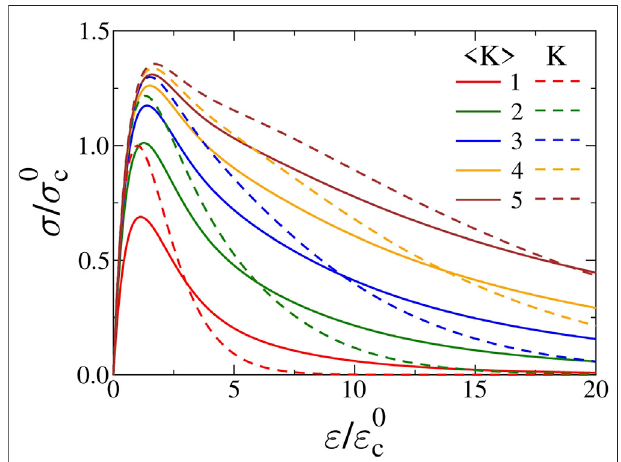
FIGURE 6 | Comparison of the constitutive curves of stick-slip bundles with constant ( dashed lines ) and fl uctuating ( continuous lines ) maximum number of slip events for the case of hardening at the stiffness parameter a (cid:1) 0 . 8. The constant K values are set to be equal to the average 〈 K 〉 of the Poissonian distribution. A natural choice for g ( K ) is the Poisson distribution.